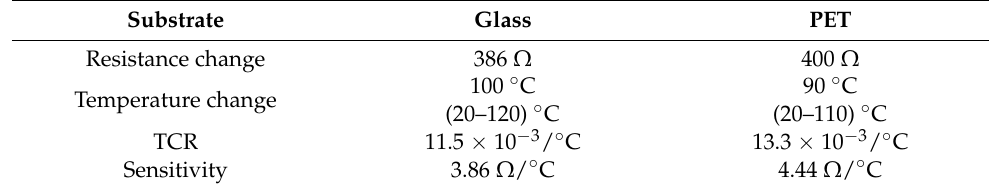
Table 3. Comparison of silver-based RTDs inkjet printed on different substrates.